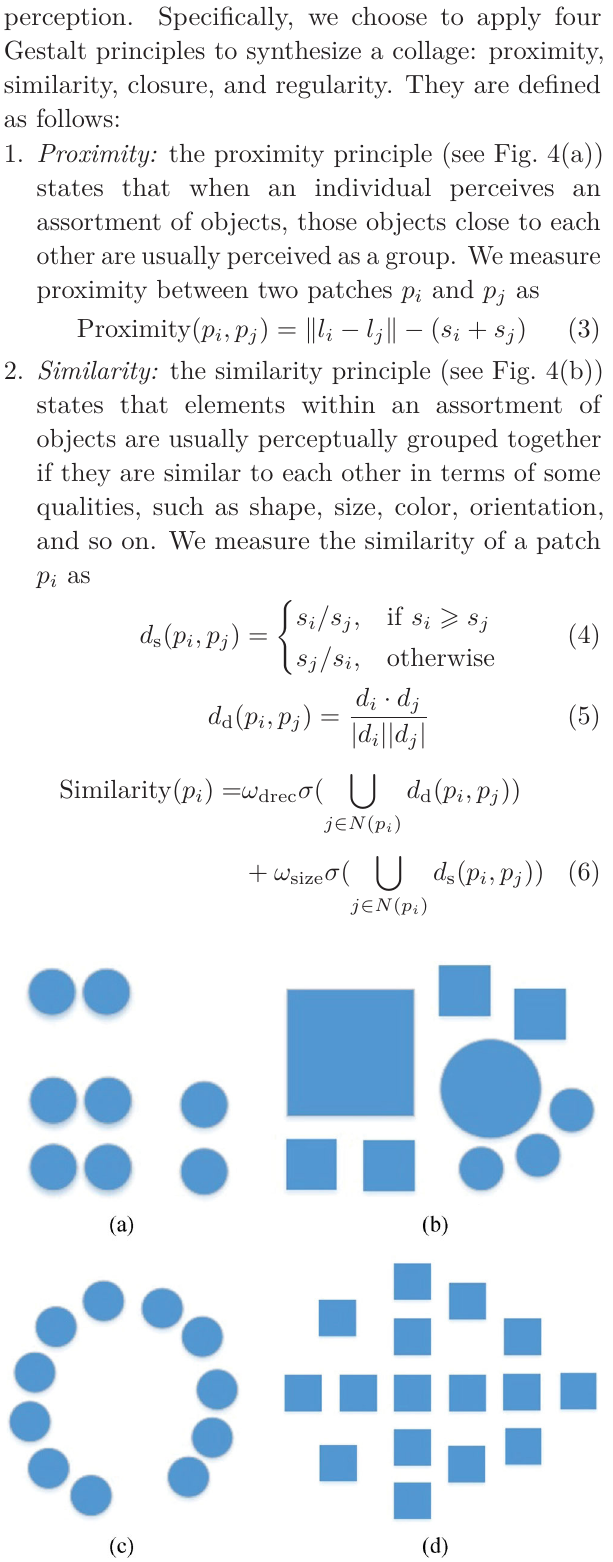
Fig. 4 Gestalt principles. (a) Proximity. (b) Similarity. (c) Closure. (d)